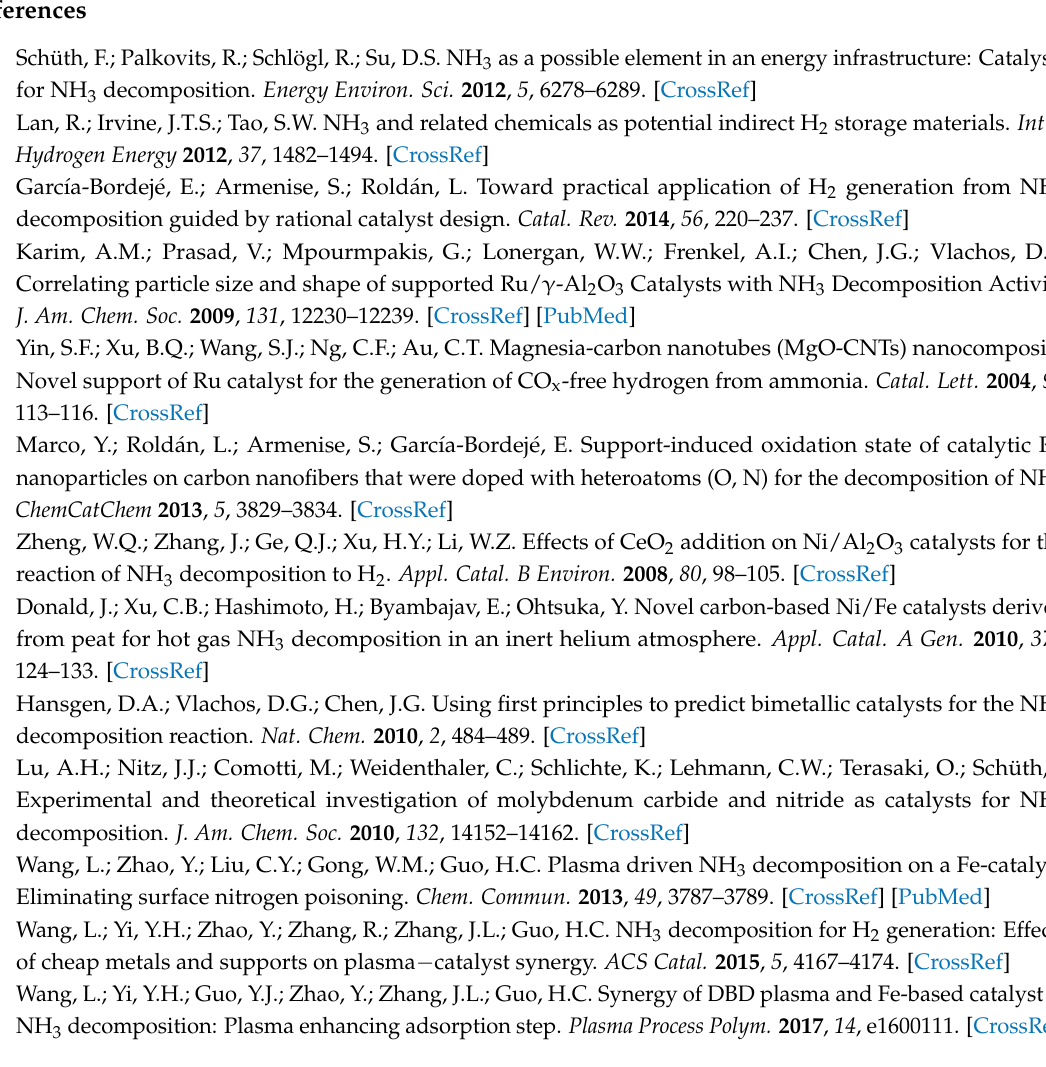
Figure S1. Peak analysis of H 2 -TPR profile obtained over Co 3 O 4 /fumed SiO 2 catalyst; Table S1. XRF analysis of Co/fumed SiO 2 with improved preparation method; Table S2. XRF analysis of Co/fumed SiO 2 with conventional preparation